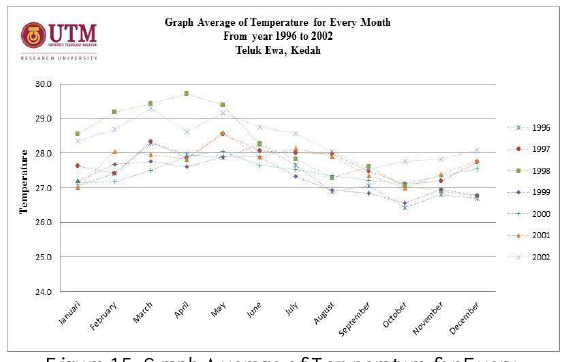
Figure 15. Graph Average of Temperature for Every